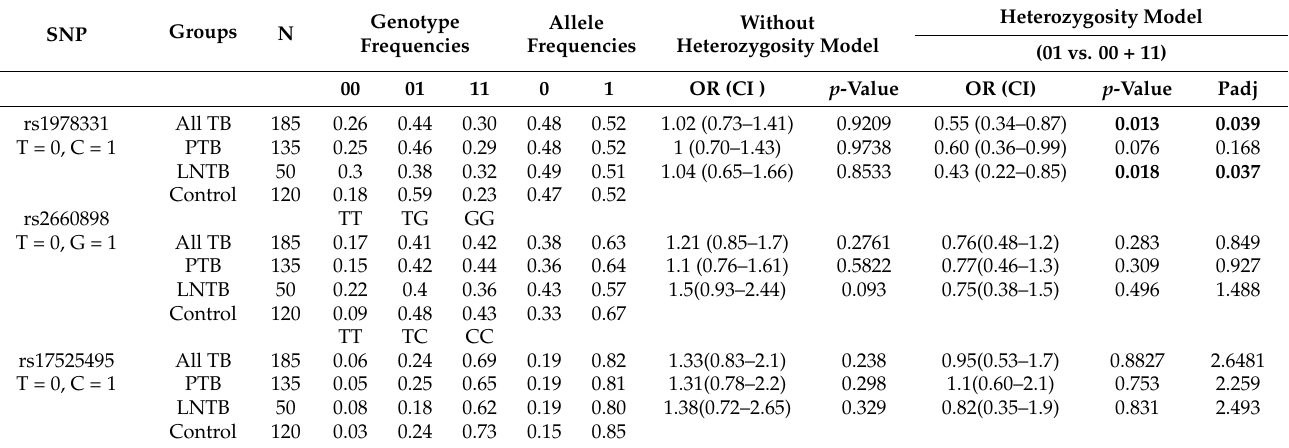
Table 6. Allelic association for the LTA4H gene with and without the heterozygosity model.